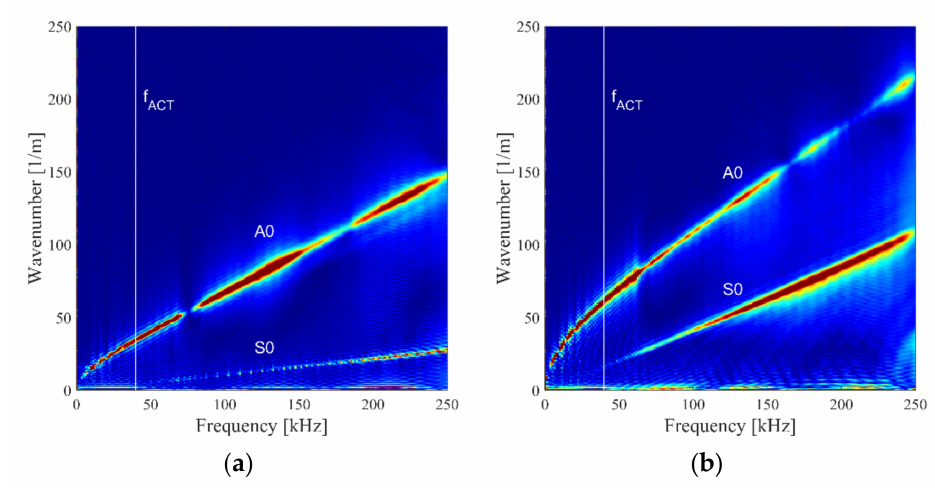
Figure 6. Dispersion curves for the CFRP plate for elastic waves excitation based on the piezoelectric transducer, in direction: ( a ) along fibers, ( b ) across